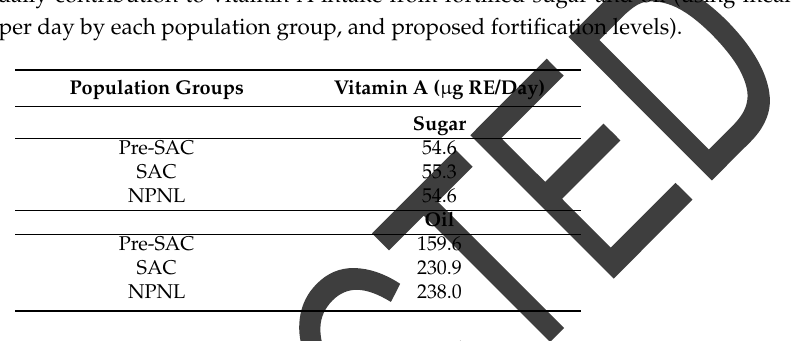
Table 6. Estimated daily contribution to vitamin A intake from fortified sugar and oil (using mean amounts consumed per day by each population group, and proposed fortification